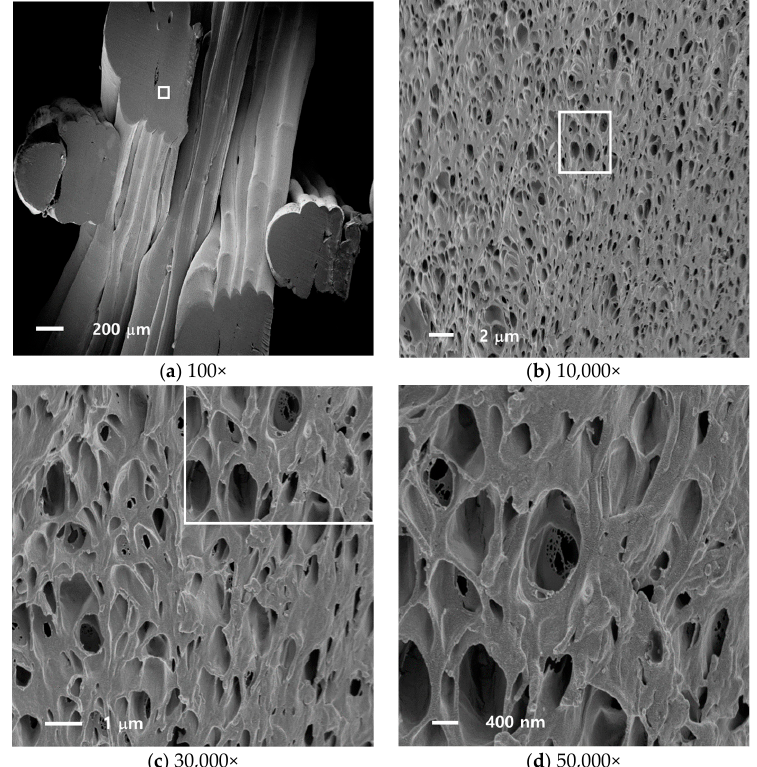
Figure 2. SEM micrographs of a 3D printed and foamed PLA structure (saturation: − 20 °C, post-foaming: 60 °C): box in ( a ) denotes zoomed-in area in ( b ); box in ( b ) denotes zoomed-in area in ( c ); and box in ( c ) denotes zoomed-in area in ( d ).